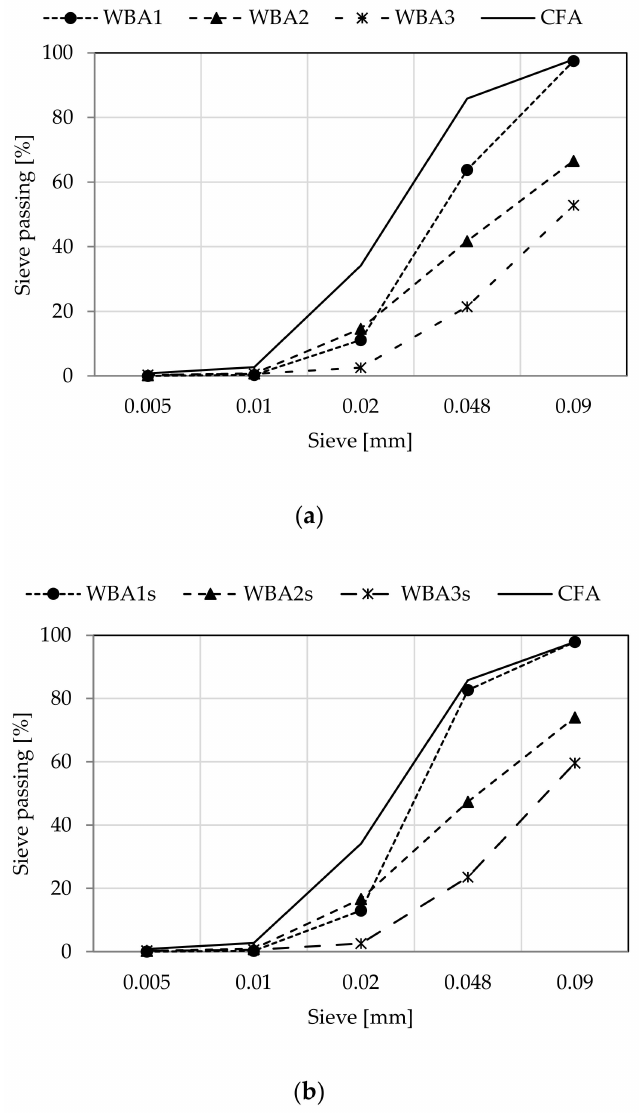
Figure 2. Particle size distribution of ( a ) non-sieved WBAs and CFA; ( b ) sieved WBAs and CFA. According to the physical requirements in EN 459-1 [23], the residue on the sieve 0.09 mm must be less than or equal to 15% of the binder mass. Of the specimens tested, only WBA1 meets the specified criteria with a percentage of particles larger than 0.09 mm of 2.51% for the non-sieved sample, and 2.13% for the sieved sample. The two samples, WBA2 and WBA3, do not meet the established criteria as the percentage of particles larger than 0.09 mm is 33.41 and 47.18% for the non-sieved samples, and 25.95 and 40.40% for the sieved samples. Screening through a 0.25 mm sieve reduces the percentage of larger particles and impurities by 17 ± 4% on